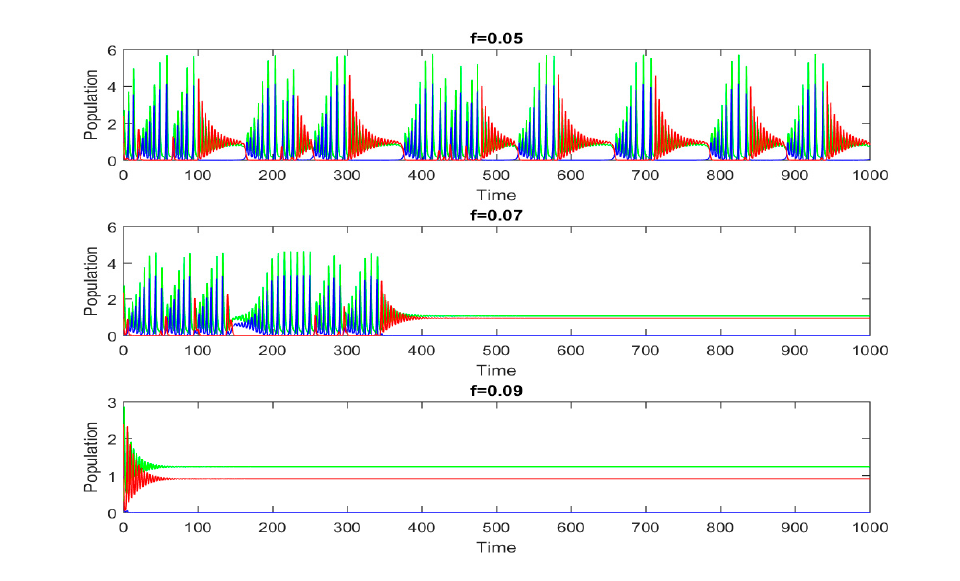
Figure 6. Time series solution at different values of f .